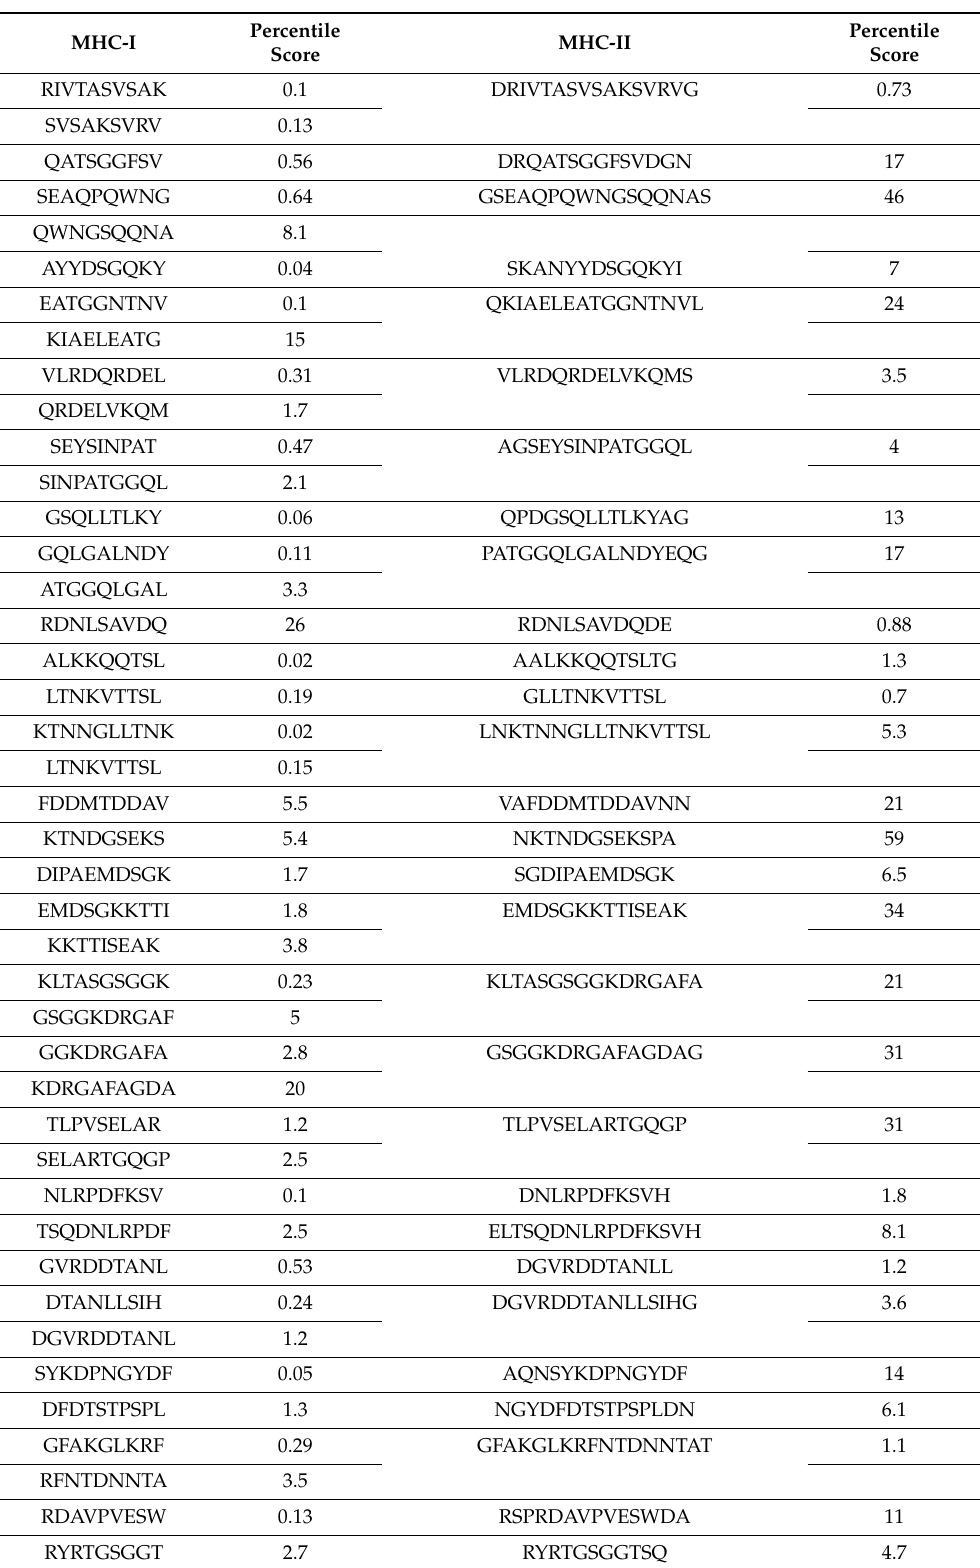
Table 7. From B-Cell epitopes, predictions of MHC-I and MHC-II